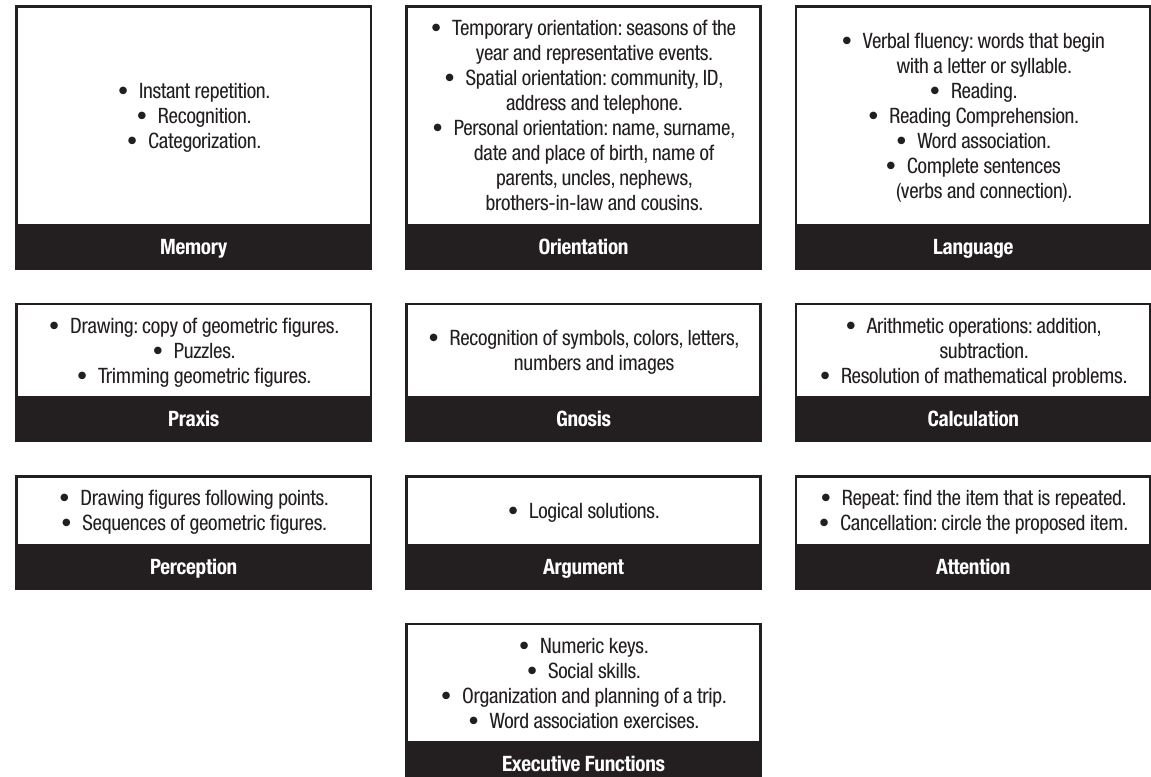
Figure 3. Cognitive stimulation exercises used based on red mental activation notebook